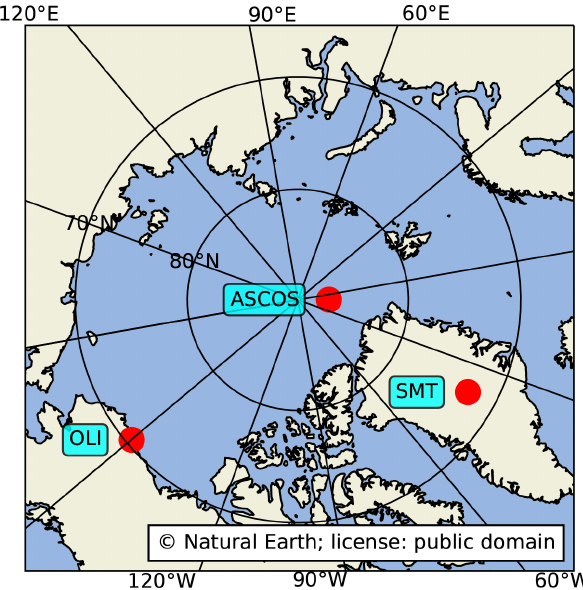
Figure 1. Map showing the locations of data taken from OLI, AS- COS, and